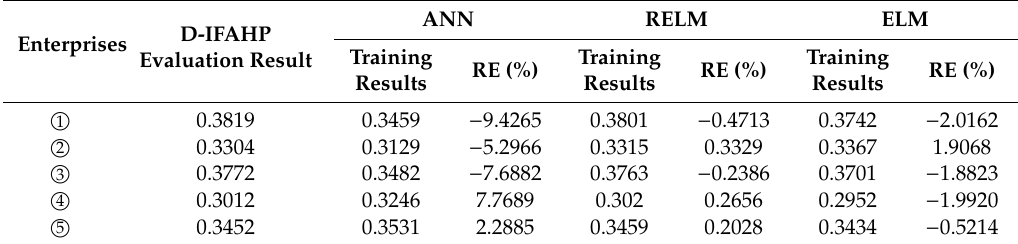
Figure 5. Training results of RELM and ELM evaluation models: ( a ) Training results of artificial neural network (ANN) model; ( b ) Training results of ELM model; ( c ) Training results of RELM model. The relative error of ANN, ELM, and RELM models are shown in Table 13. Table 13. The relative error of ELM model and evaluation results.